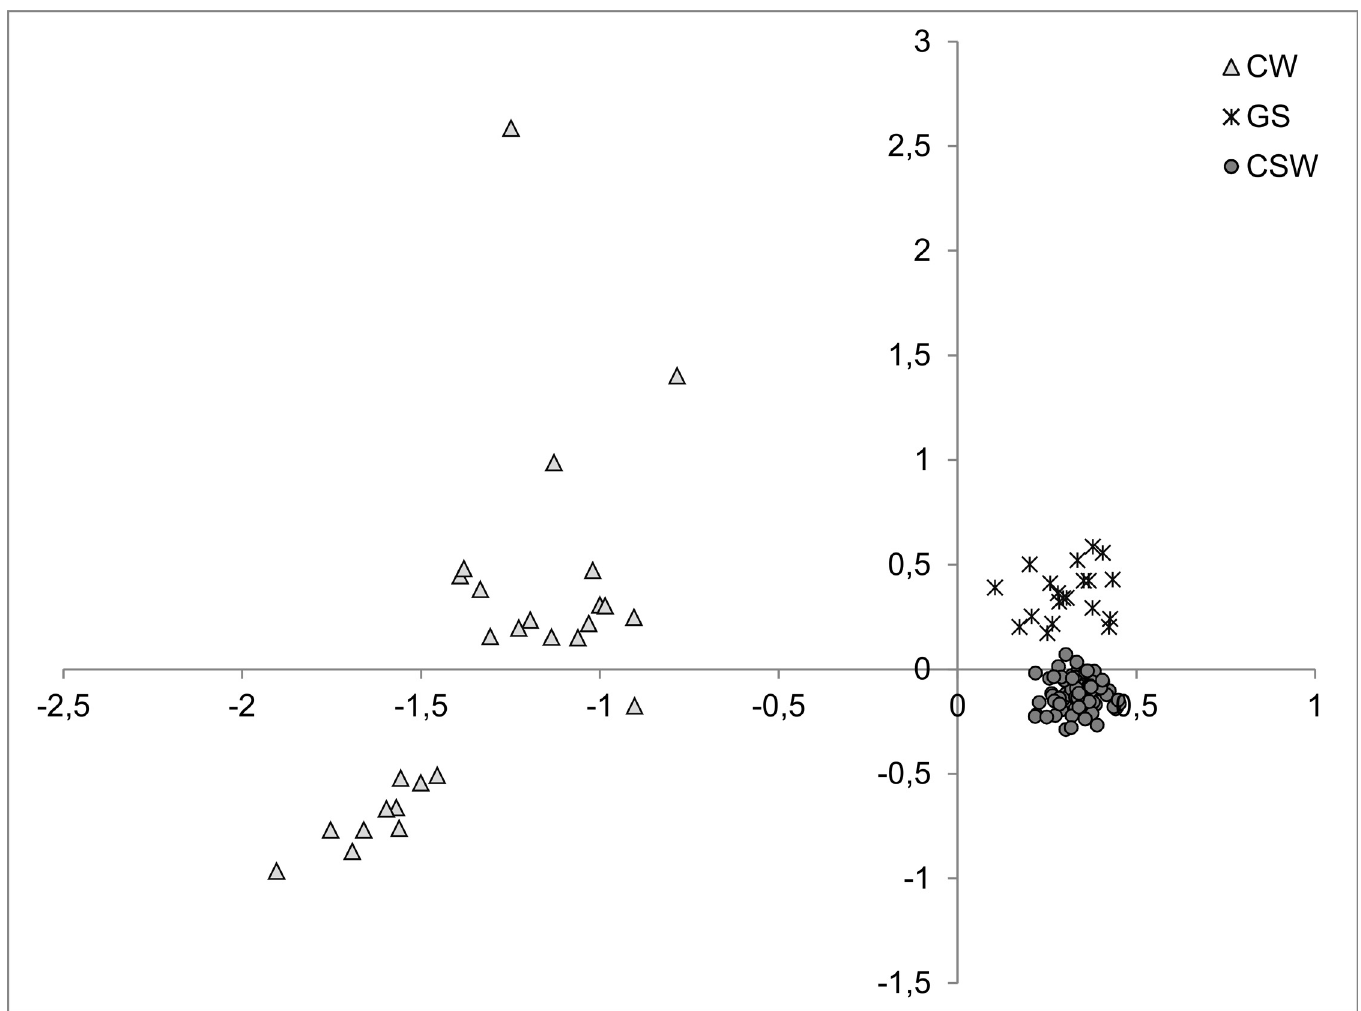
Fig 2. A two-dimensional plot of the factorial correspondence analysis performed in Genetix. CW = Carpathian wolves, GS = German Shepherds, CSW = Czechoslovakian Wolfdogs. N E E STIMATOR showed a high concordance between the results obtained considering P Crit = 0 and P Crit = 0.02, from which the effective CSW population size was Ne = 76.5 (95% CI: 68.2 – 86.5) and Ne = 82.9 (95% CI: 72.3 – 96.4),